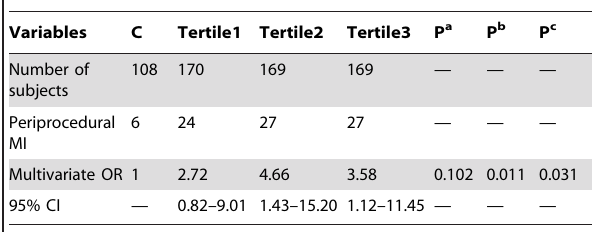
Table 3. Logistic regression analysis of the effect of calcification on periprocedural myocardial infarction in the four groups.